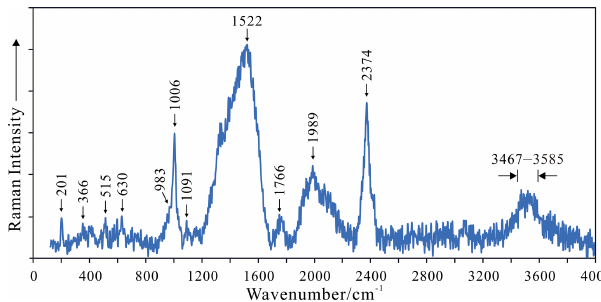
Figure 3. Raman spectrum for bobtraillite. Table 1. Chemical data (wt%) for